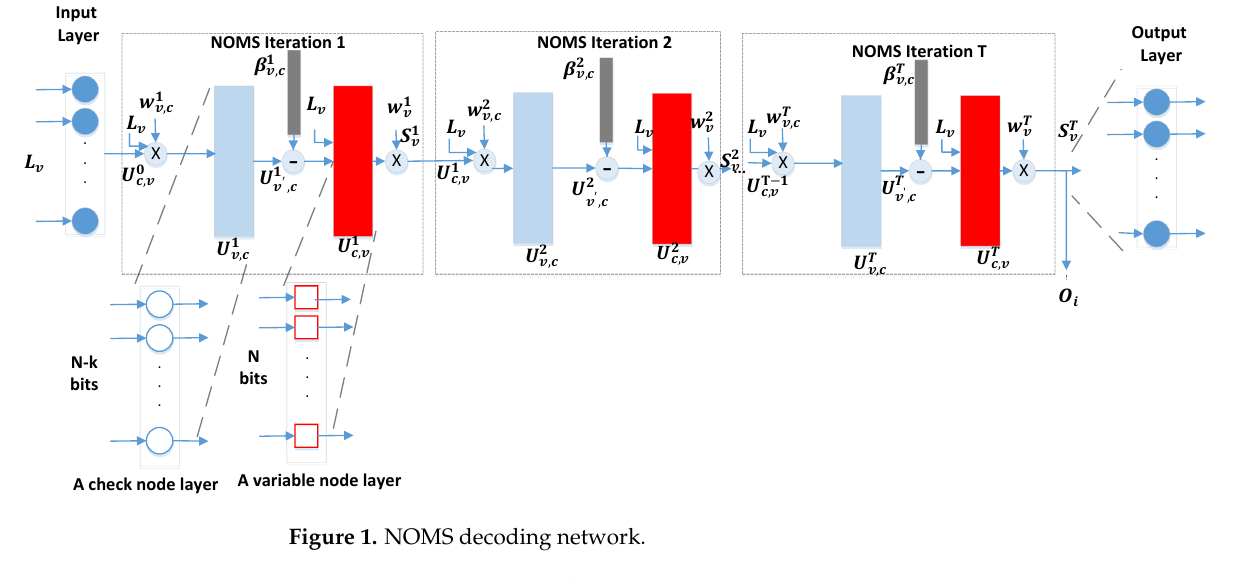
Figure 1. NOMS decoding